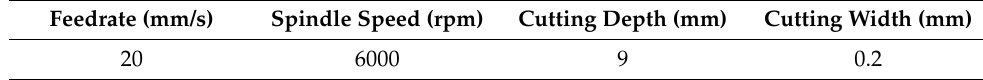
Table 3. The cutting parameters of the cardioid curve. Feedrate (mm/s)